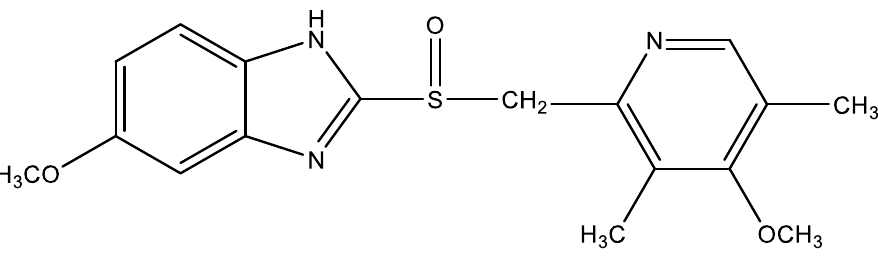
Figure 1. Structural formula of omeprazole.